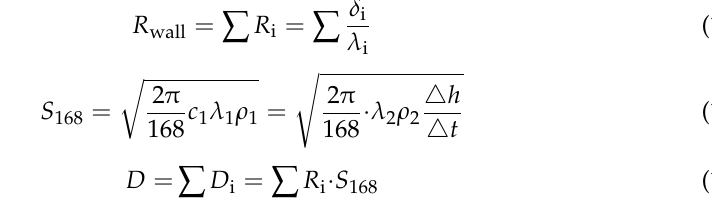
Figure 2. Physical model of grain bin wall (L1: 40 mm; L2: 330 mm).